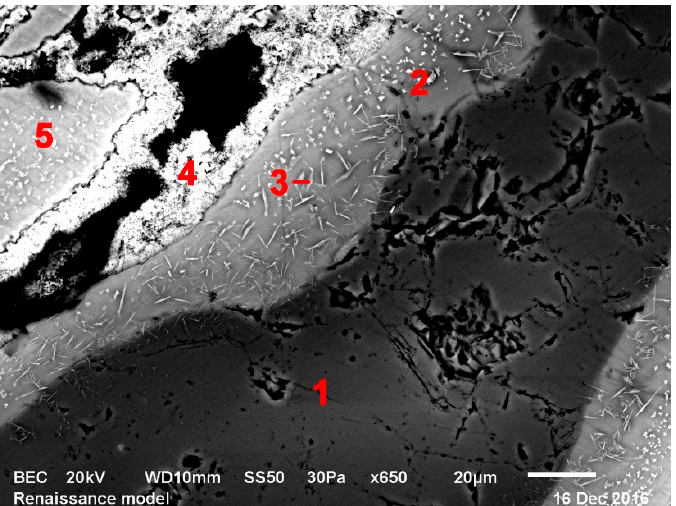
Figure 5. Model Renaissance glass exposed to 800 °C, bi-product layers around SiO 2 , SEM; 1—SiO 2 core, 2, 3, 5—potassium-calcium silicates, 4—calcium-potassium silicates.